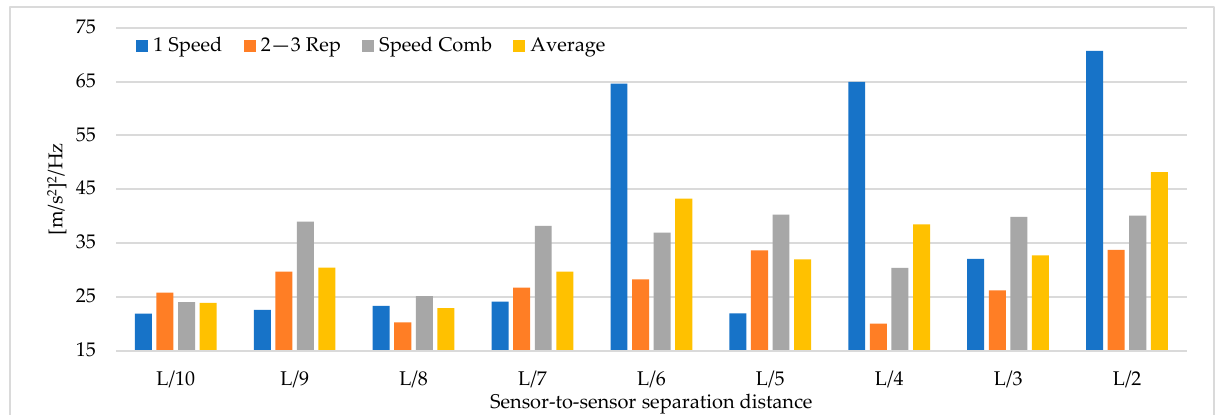
Figure 8. The magnitude of the power spectrum for different sensor-to-sensor separation distances (Units: [m/s 2 ] 2 /Hz).